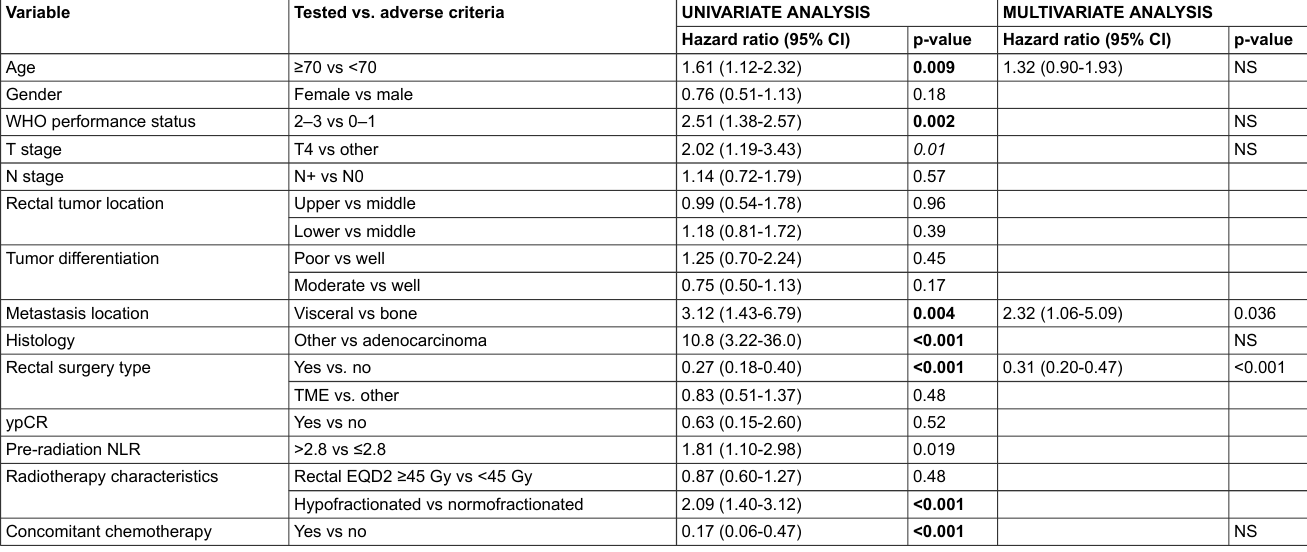
Table 4: Predictive factors for overall survival in the whole set of patients (n = 148).